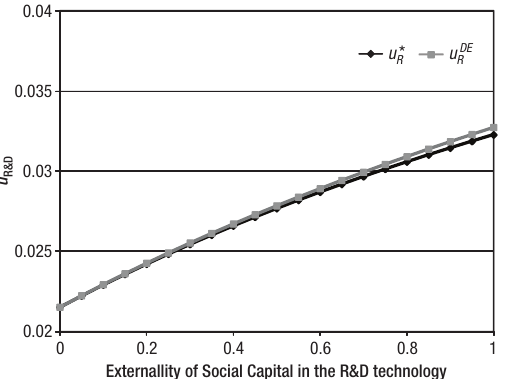
Fig. 6. Comparison between DE